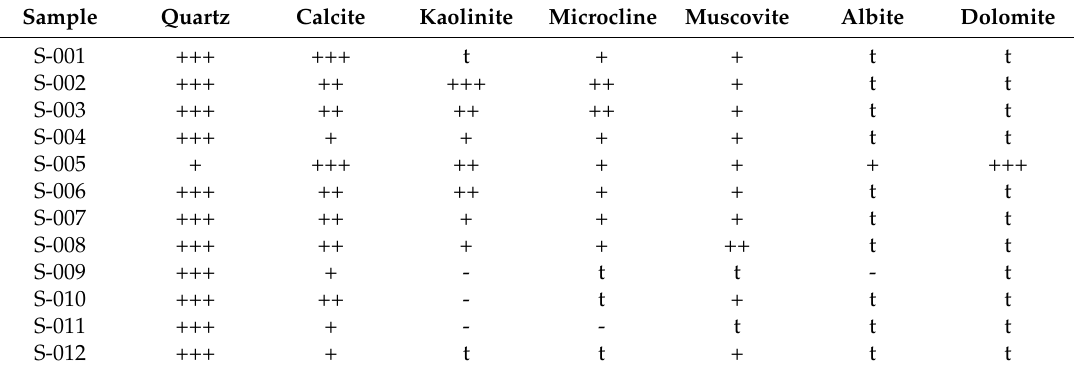
Table 1. Mineralogical composition of the mortars assessed by X-ray Powder Diffraction (XRPD). Sample Quartz Calcite Kaolinite Microcline Muscovite Albite Dolomite